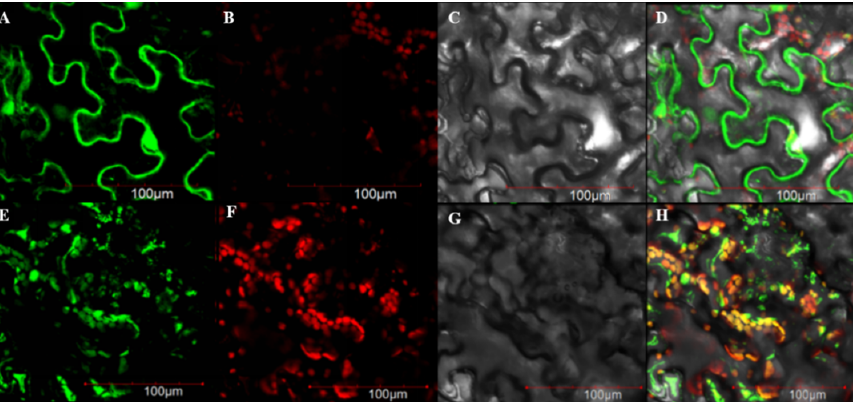
Figure 4. Transient expression of BrSHINE3 in tobacco epidermal cells. ( A , E ) GFP is fluorescence field; ( B , F ) is chloroplast channel; ( C , G ) is open field; ( D , H ) is Merge, which means superposition;